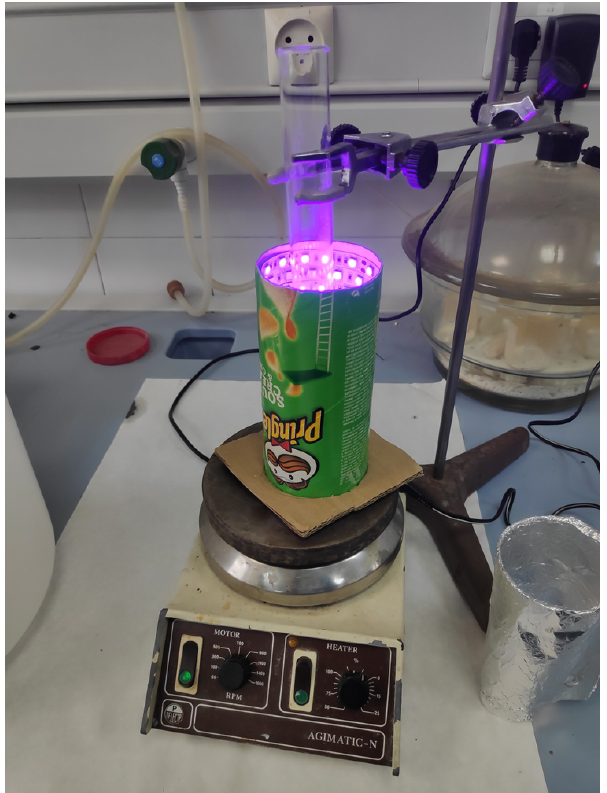
Figure 1. Handmade photoreactor that only allows visual control of the reaction extent in discontinu- ous